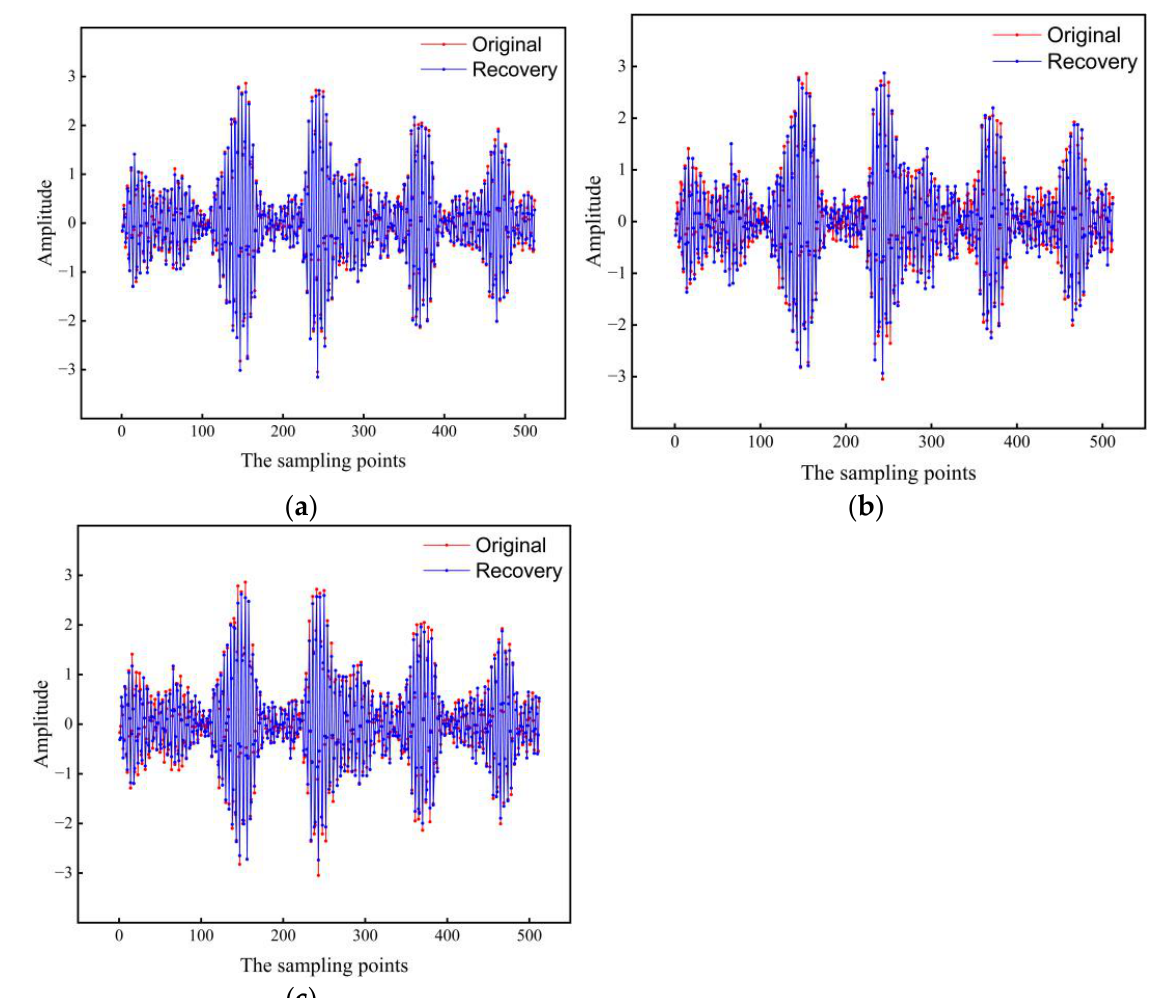
Figure 4. AOA-CS Algorithm to recover the mechanical vibration signal compared with the original vibration signal. ( a ) AOA-CS; ( b ) OMP; ( c ) BP.